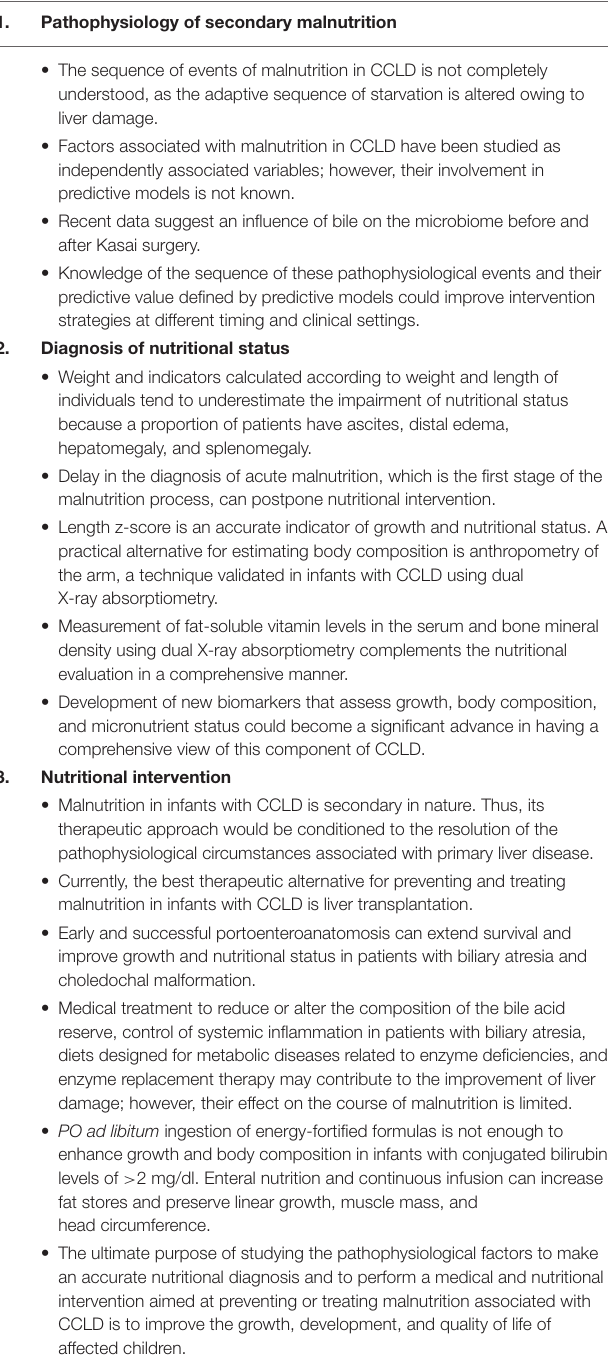
TABLE 1 | Current practices, controversies, and possible future developments related to the pathophysiology, diagnosis, and nutritional intervention of CCLD associated to secondary malnutrition in